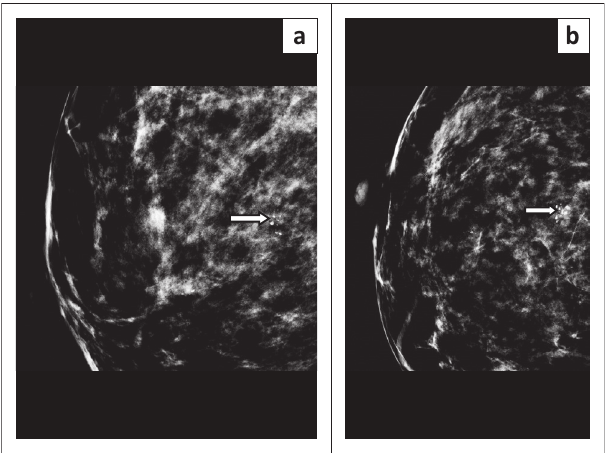
FIGURE 1: (a) Mediolateral and (b) craniocaudal mammography projections demonstrating clustered indeterminate calcifications in the right breast (arrows).